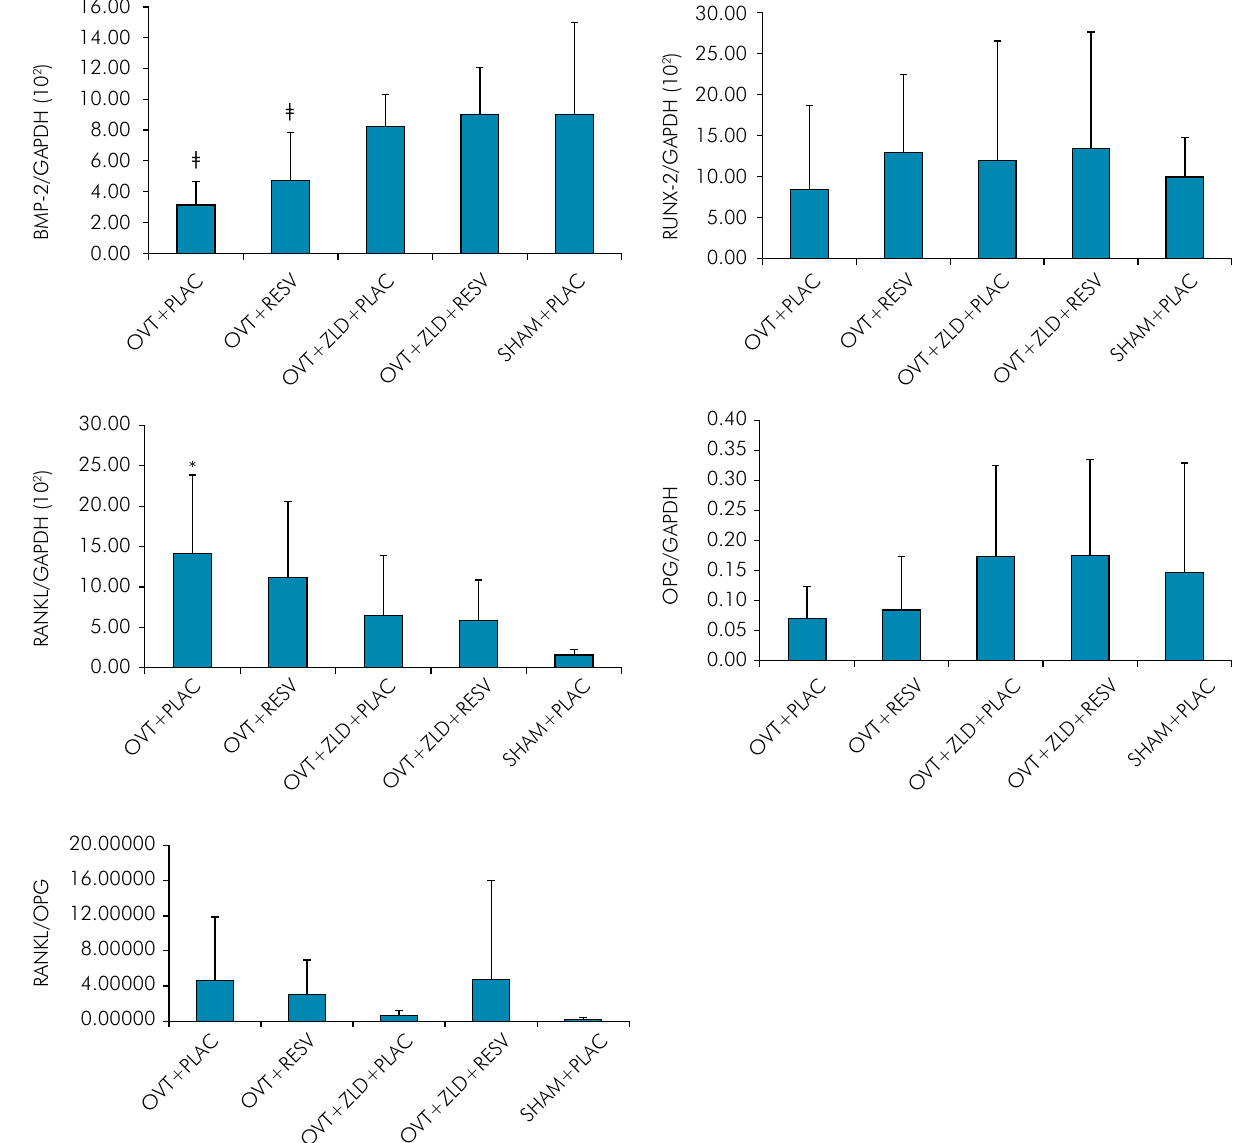
Figure 4. Means and standard deviations of gene expression